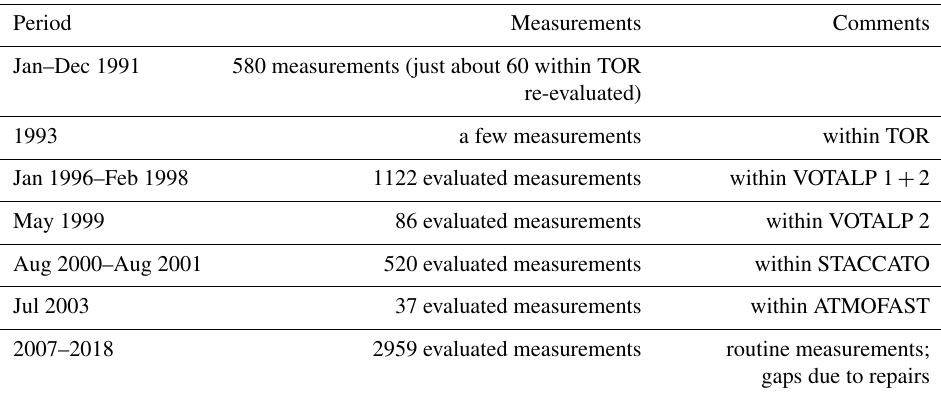
Table 3. Measurement periods of the stationary DIAL. Projects: TOR (EUROTRAC subproject Tropospheric Ozone Research a ) , VOTALP (Vertical Ozone Climate on Atmospheric Transport and Oxidation Capacity c ) , ATMOFAST (German abbreviation of “Atmospheric Long-range Transport and its Impact on the Trace-gas Concentrations in the Free Troposphere over Central Europe” d ) ; for references see text.